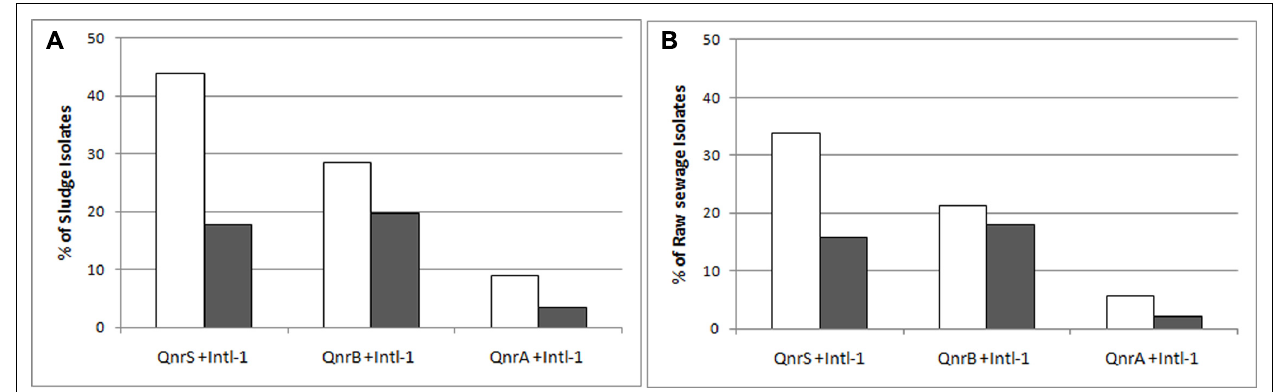
FIGURE 5 | White bars : the relative abundance of intermediate ciprofloxacin-resistant isolates carrying qnr variants (A, B, S) from the sludge (A), and raw sewage (B); Gray bars : the abundance of intl-1 positive isolates among those qnr -positive isolates.